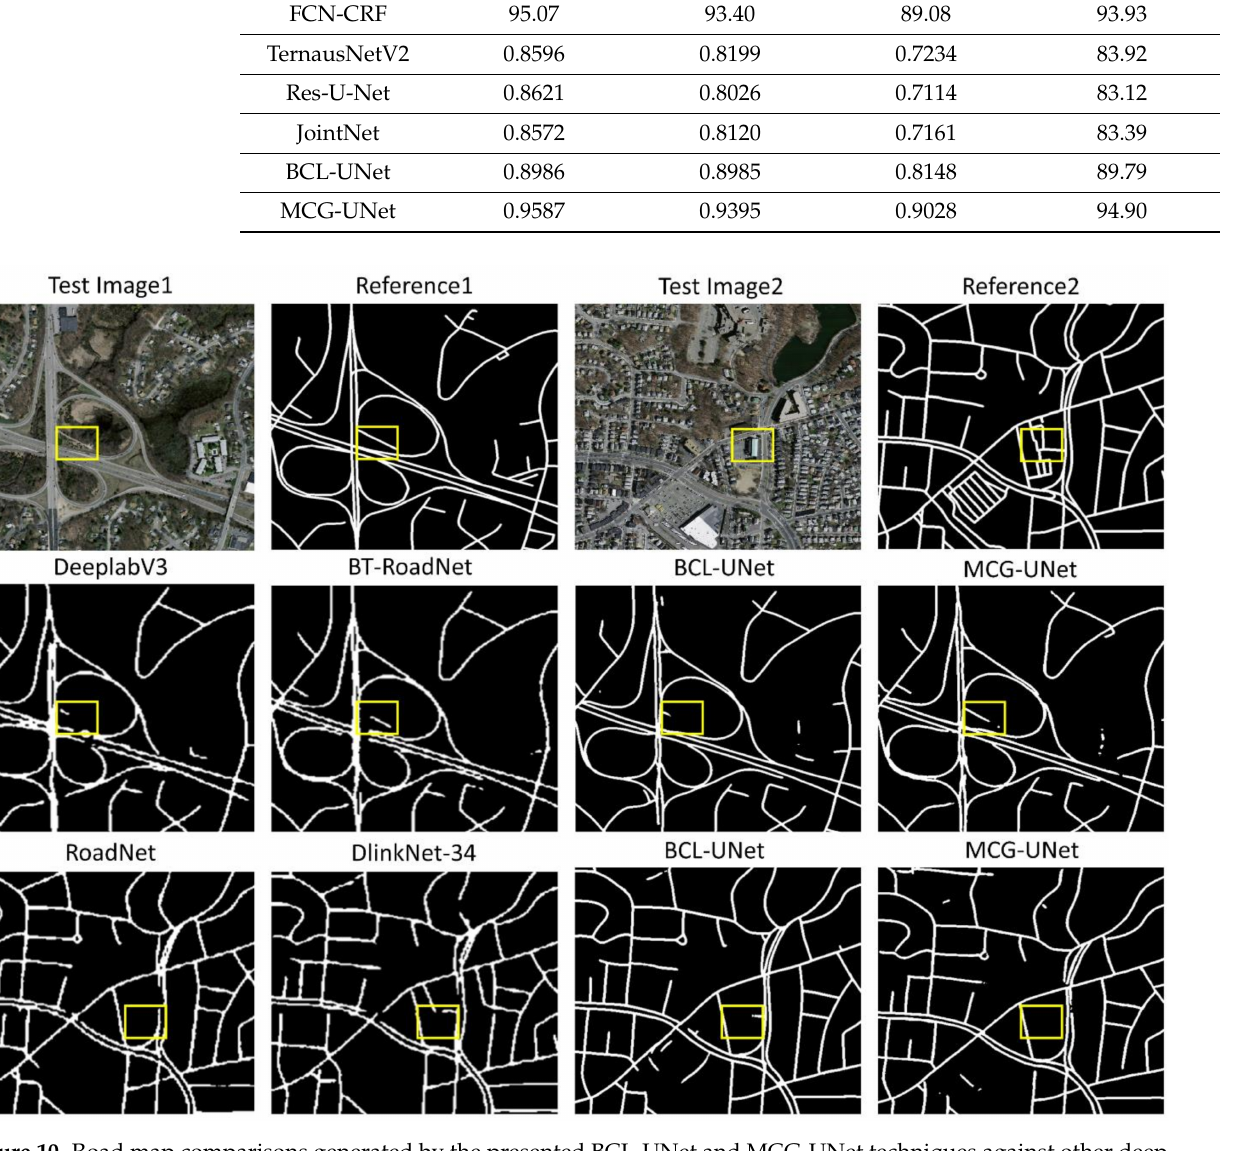
Figure 10. Road map comparisons generated by the presented BCL-UNet and MCG-UNet techniques against other deep learning-based networks. The yellow boxes show the predicted FPs and